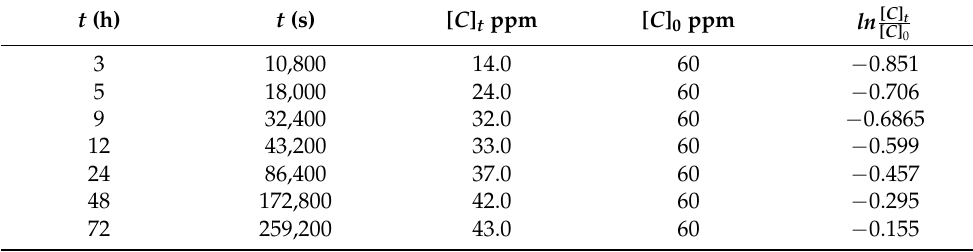
Table 2. Values of first order and second order equations based on time